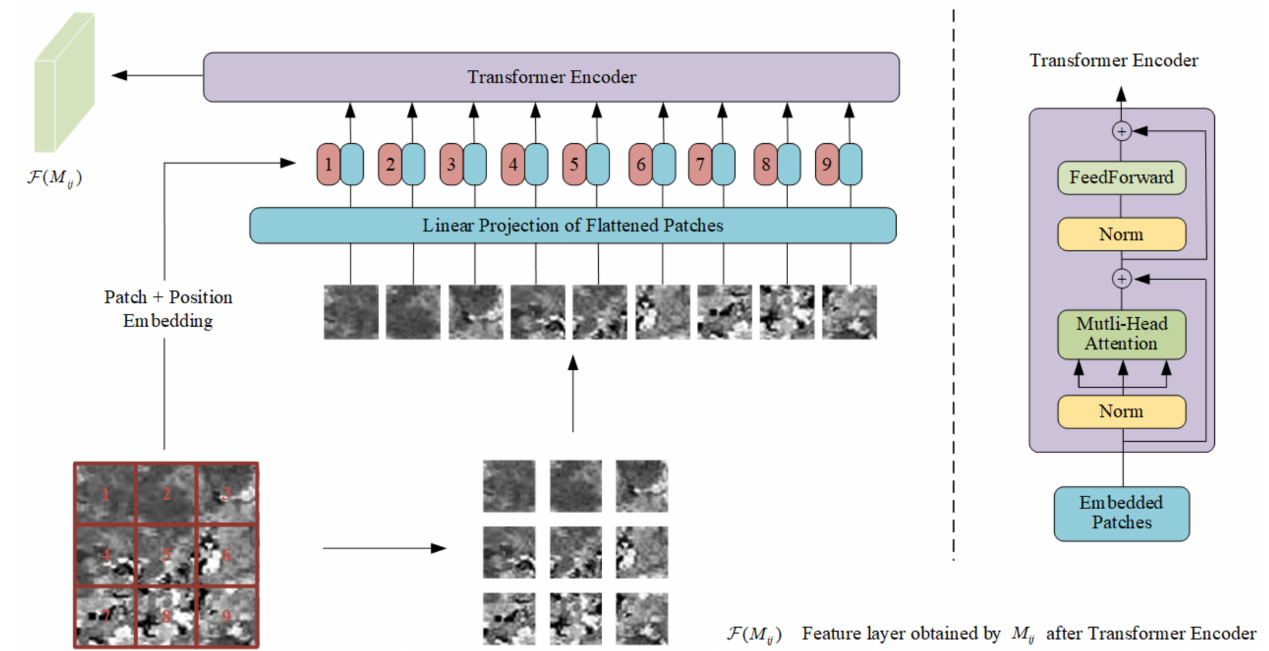
Figure 2. Transformer encoder applied to spatiotemporal